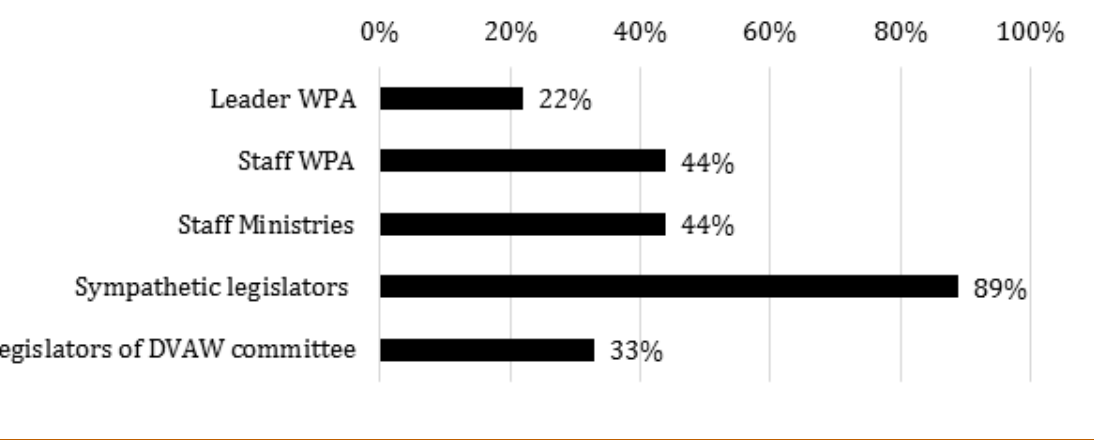
Figure 1: Mechanisms used to in(cid:976)luence the political sphere in Argentina